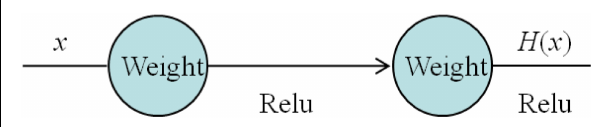
FIGURE 2 | General neural network.